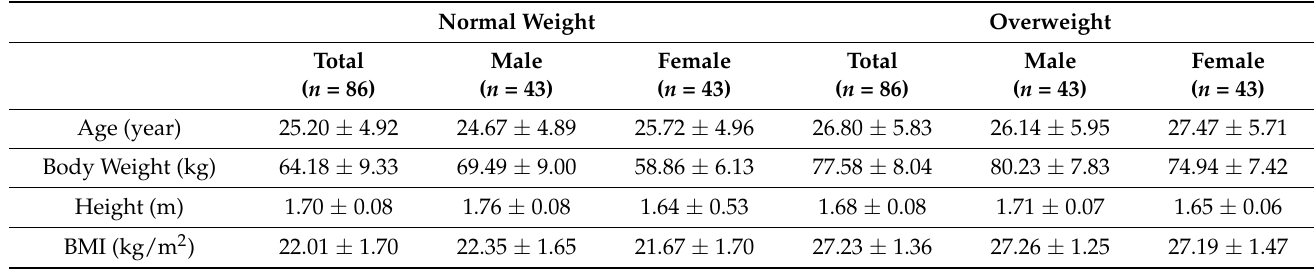
Table 1. Descriptive variables for BMI groups in both males and females.